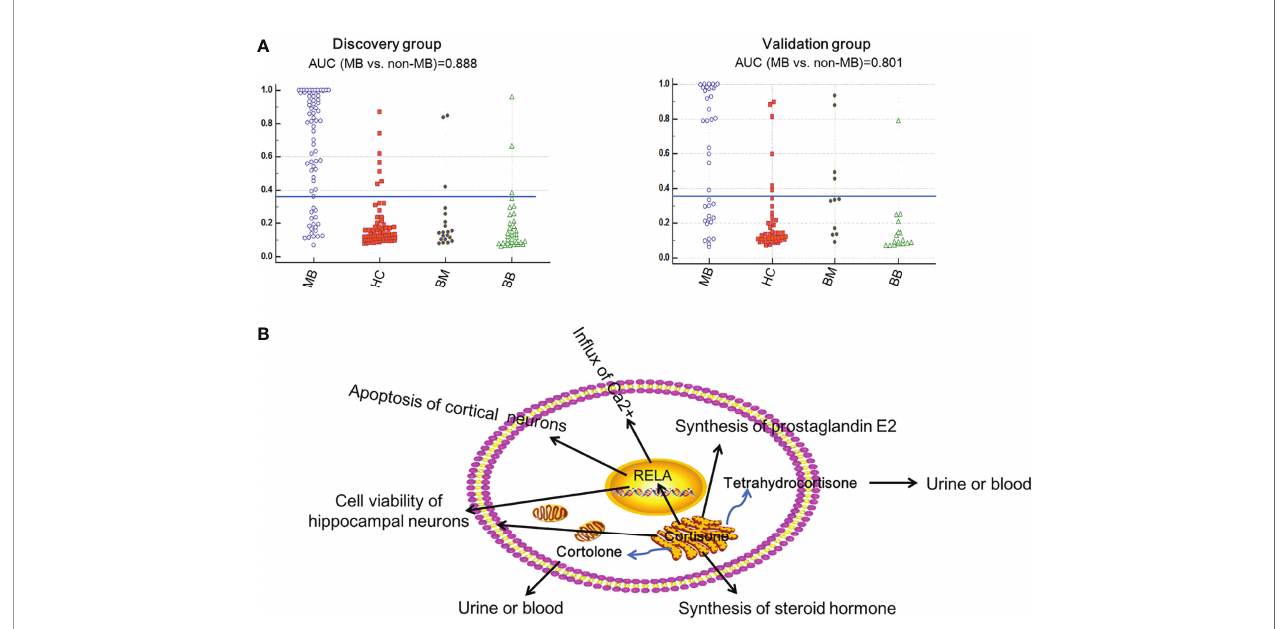
FIGURE 4 | MB prediction using the metabolites tetrahydrocortisone and cortolone. The prediction accuracy of the metabolite panel (tetrahydrocortisone and cortolone) for MB in the discovery and validation groups (A) . The possible functions regulated by tetrahydrocortisone and cortolone in MB (B)